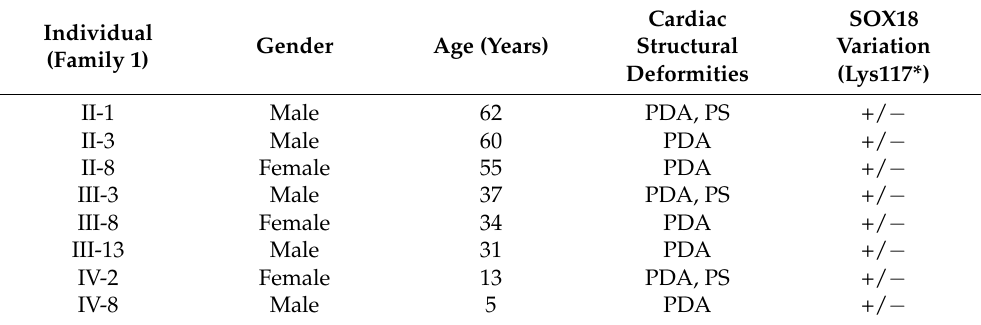
Figure 2. A representative echocardiographic image of the proband’s patent ductus arteriosus. The color flow image shows the presence of a patent ductus arteriosus between the left pulmonary artery and the descending aorta. DAO, descending aorta; LPA, left pulmonary artery; PDA, patent ductus arteriosus. Table 1. Clinical phenotypic data and SOX18 variation status of the living pedigree members affected by congenital cardiovascular